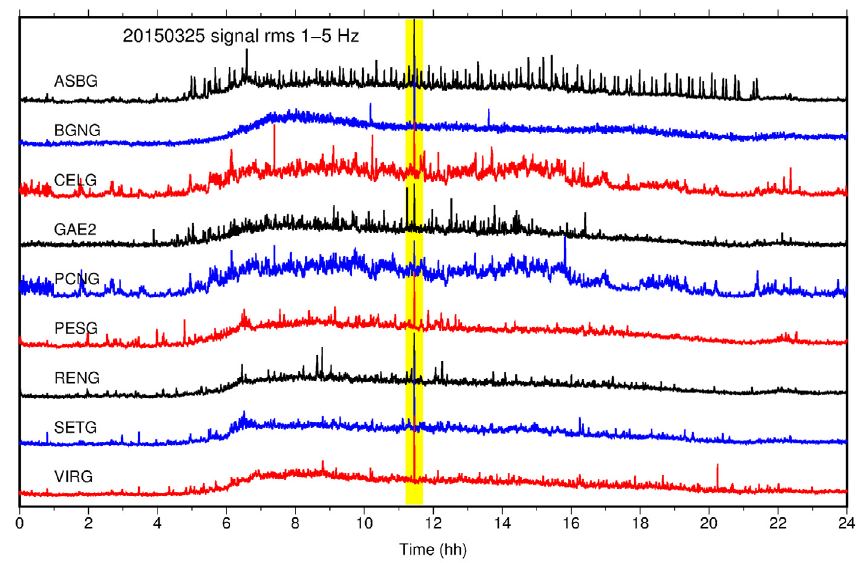
Figure 7. Average rms (among the three components) of the seismic signals recorded by many stand-alone stations in the Campi Flegrei area on March 25, 2015. Signals were bandpass filtered between 1 Hz and 5 Hz, and the rms was computed over 10 s sliding window. The yellow background color marks an amplitude peak common to all stations, representative of a LF